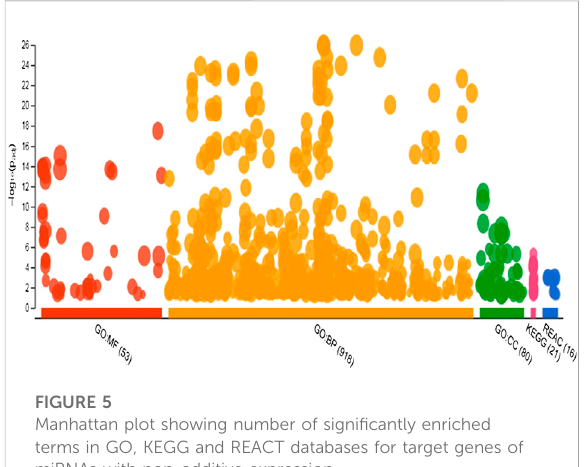
FIGURE 5 Manhattan plot showing number of signi fi cantly enriched terms in GO, KEGG and REACT databases for target genes of miRNAs with non-additive